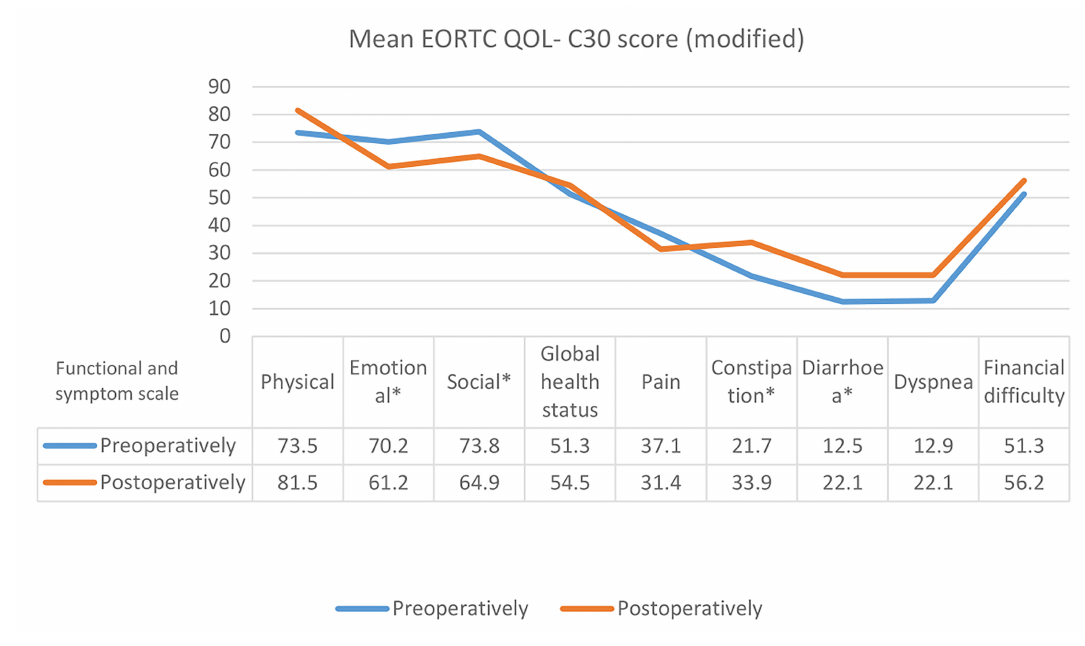
Figure 3 - EORTC QLQ-C30 scores preoperatively and at the end of the 12-month follow-up period. Asterisk (*) denotes statistically significant difference between samples (p